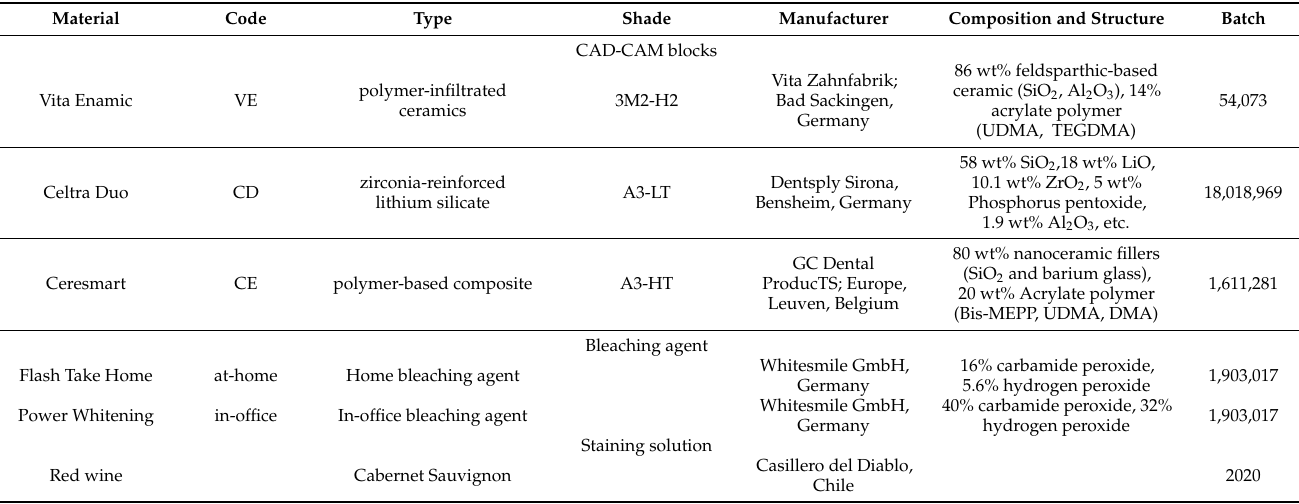
Table 1. Materials and bleaching agents used in the present